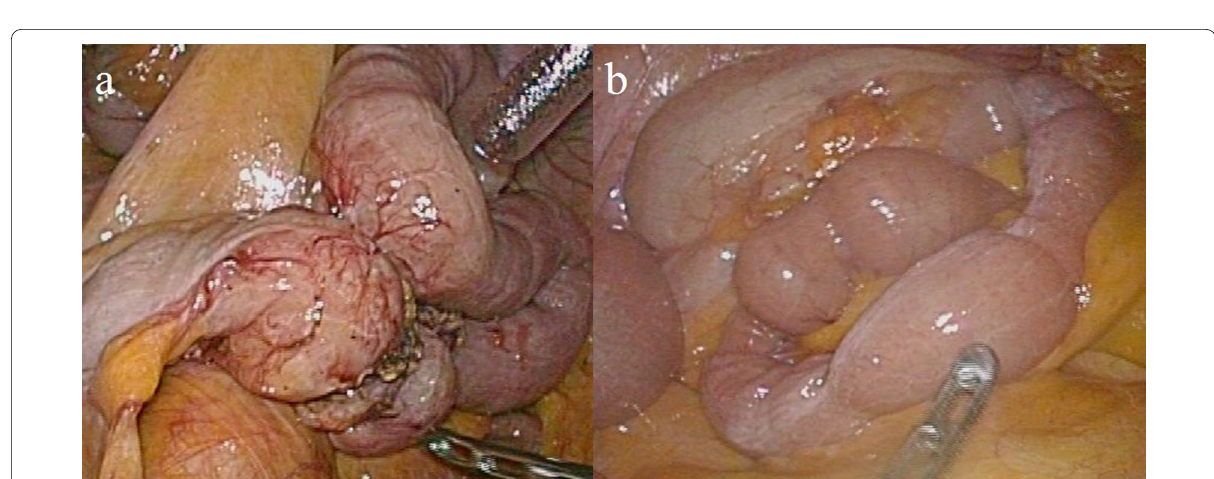
Fig. 3 Intraoperative findings. Stenosis part of the ileum showed constriction of the serosa, without any obvious findings of ischemia ( a ). There were no inflammatory or ischemic lesions in the remaining part of the small bowel, mesentery, and intra-abdominal fat ( b